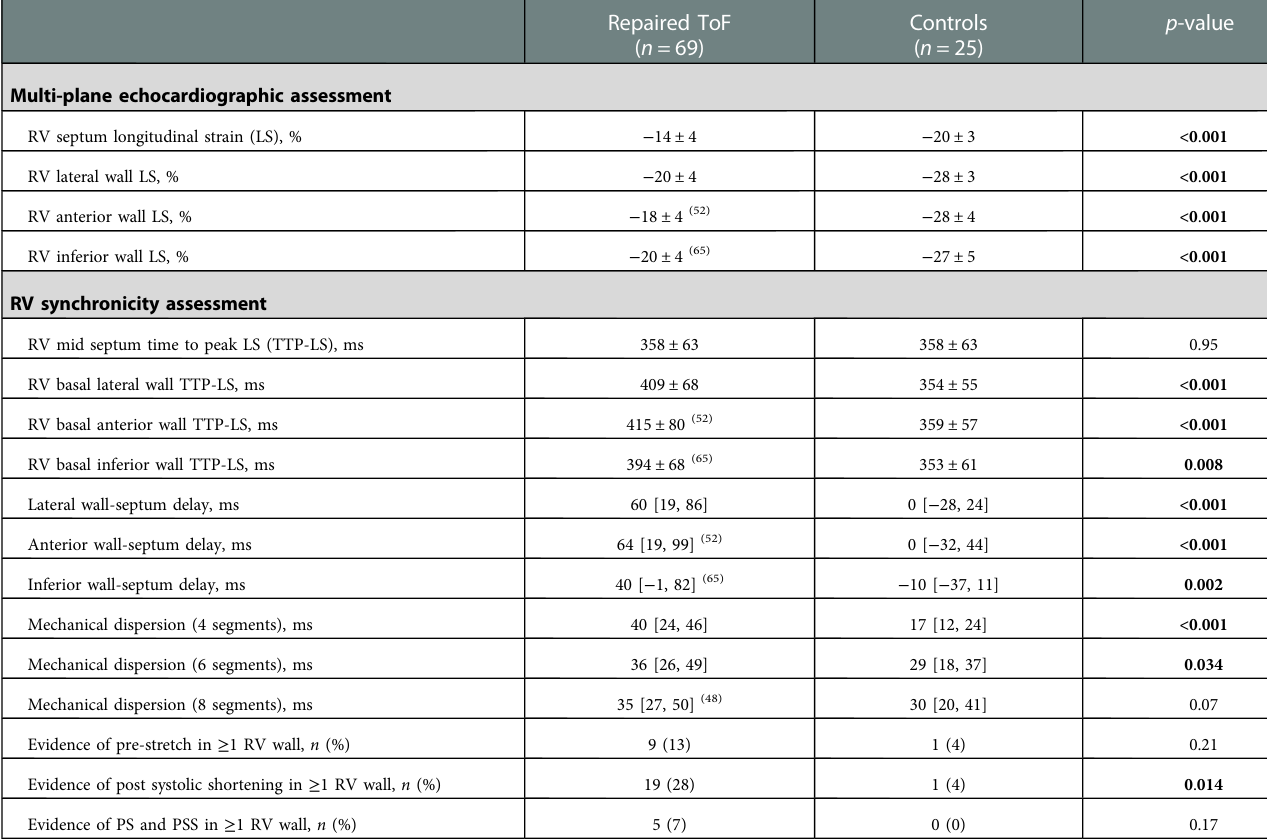
TABLE 3 RV deformation and synchronicity parameters in ToF patients and controls.